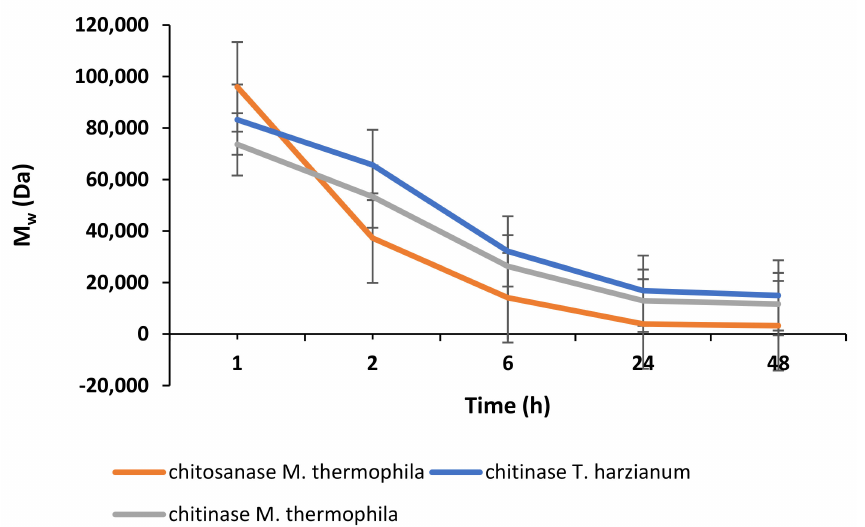
Figure 2. Kinetics of the changes in molecular weight of chitosan from H. illucens larvae during enzymatic hydrolysis.